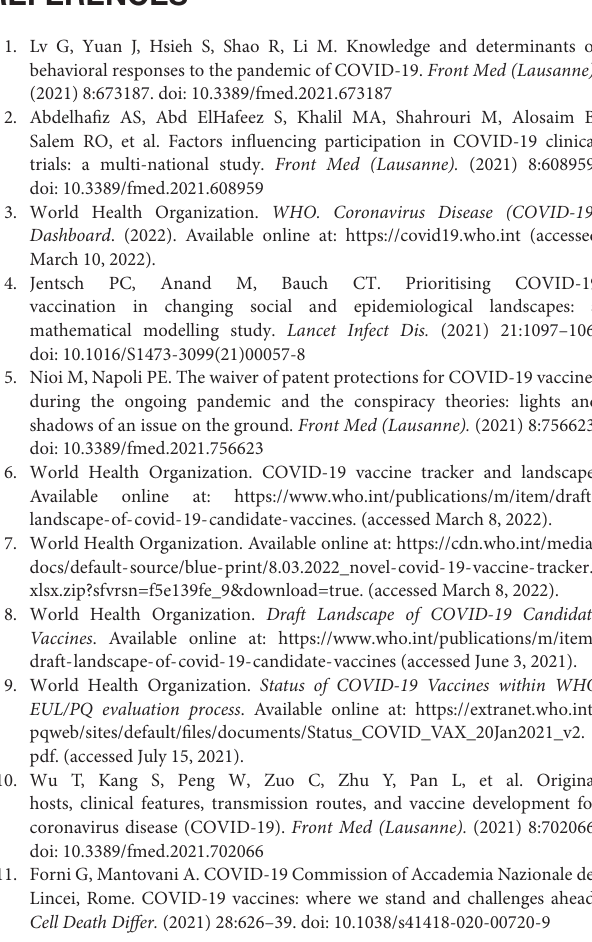
Supplementary Table 1 | Characteristics of the studies included. Supplementary Table 2 | Results of the Egger test, the heterogeneity test, and the